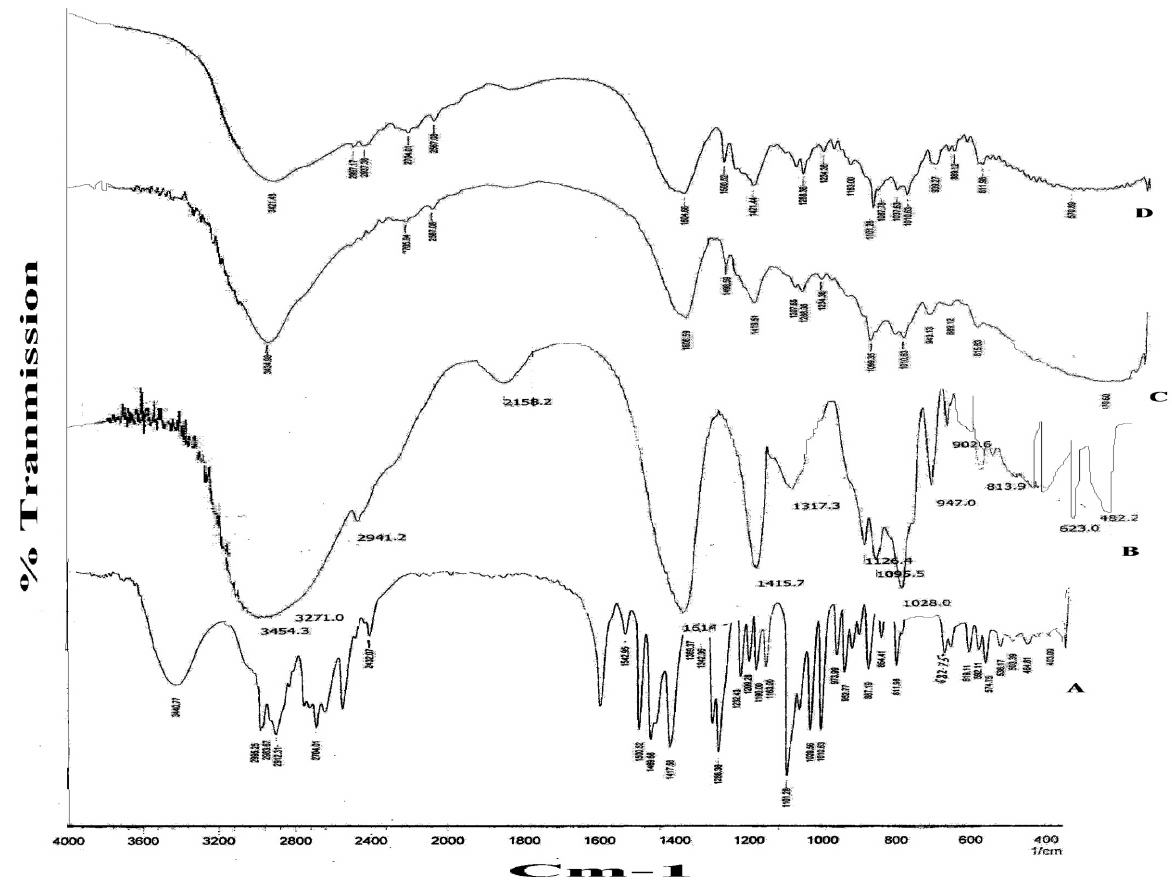
FIGURE 2 - FTIR spectra of TMZ (A), Sodium alginate (B), TMZ-loaded beads prepared by sequential method (C), TMZ loaded- beads prepared by simultaneous method